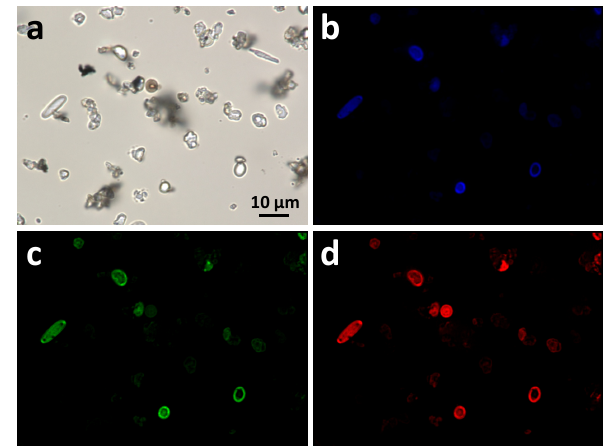
Fig. 7. Microscopy pictures of ambient aerosol sample. Illumi- nation source: (a) brightfield, (b) λ ex =340–380nm, λ em =435– 485, (c) λ ex =465–495nm, λ em =510–560, (d) λ ex =540–580nm, λ em